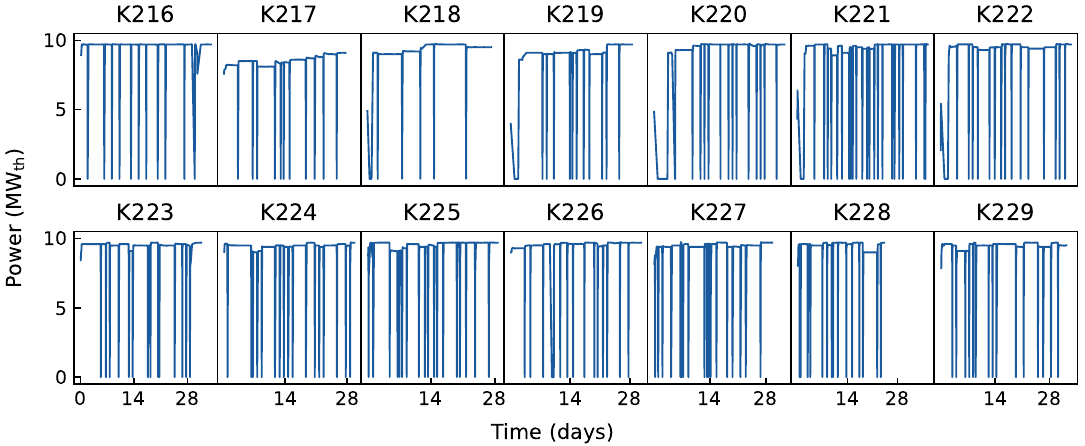
Figure 2. Power sequence of the LVR-15 reactor operation including cycles